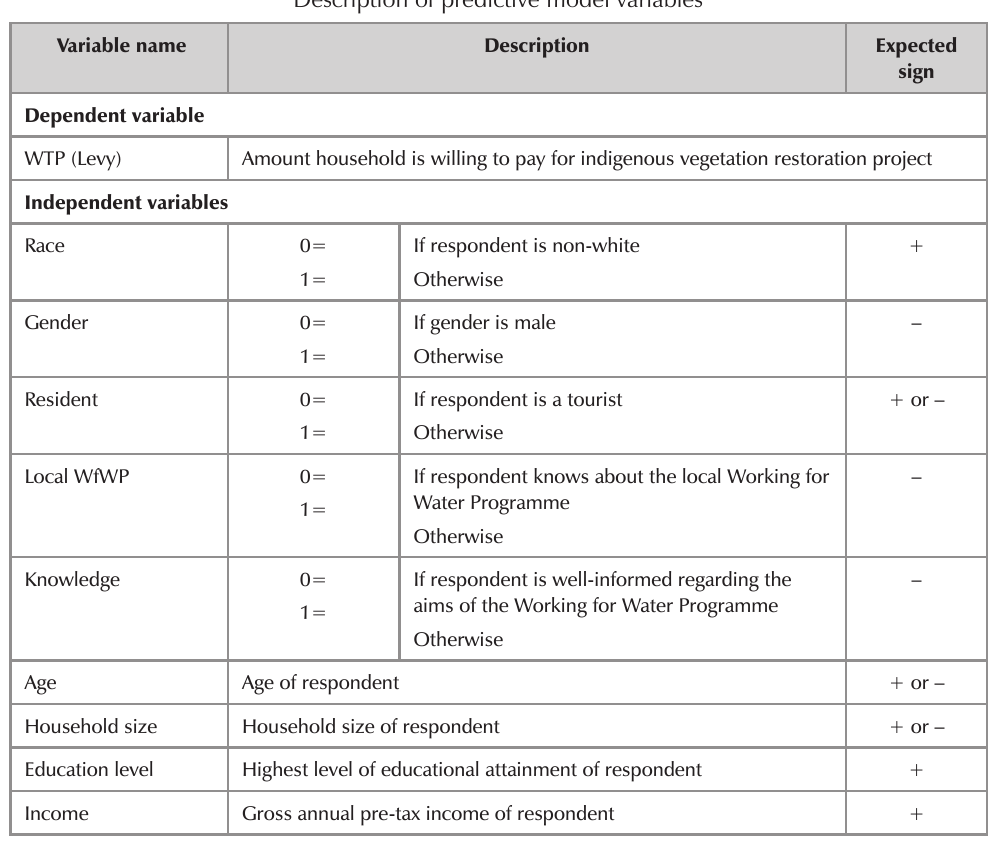
Description of predictive model